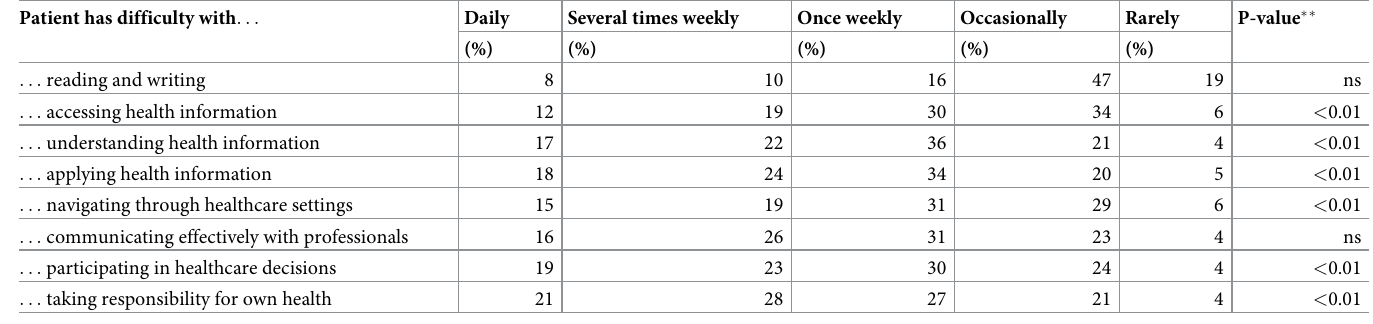
Table 2. Self-reported encounters with patients who have difficulties with specific HL skills (N = 396). Patient has difficulty with